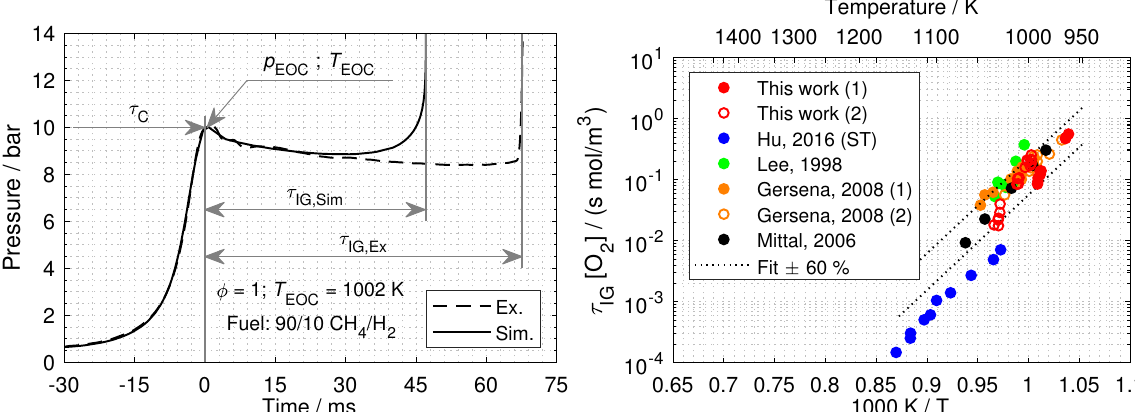
Figure 2. ( Left ): Pressure trace of an RCM experiment with its corresponding simulation (same initial conditions, p 0 = 0.6bar, T 0 = 411K). ( Right ): Ignition delay times of H 2 at stoichiometric conditions scaled by the O 2 concentration compared with data from the literature. Data from: Gersen, 2008 (1&2) [14], Hu, 2016 [24], Lee, 1998 [12] and Mittal, 2006 [13].